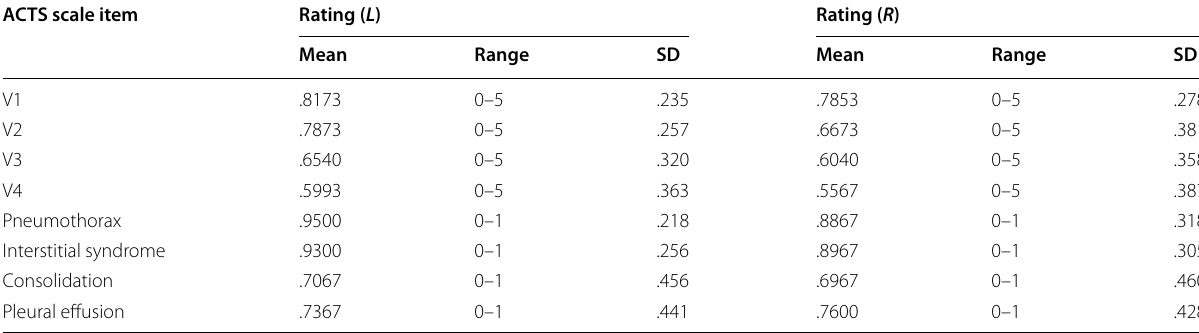
Ratings are provided in rescaled values (.0–1.0) whereas the range is reported using the range provided on subscale used to assess learners (i.e., 0–5 and 0–1)